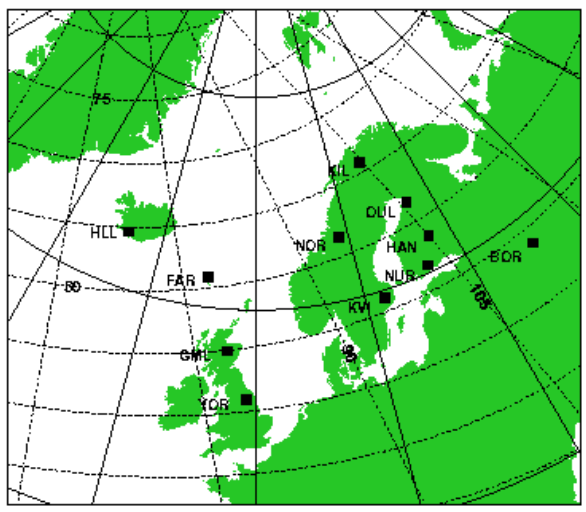
Fig. 10a. Map of stations in the SAMNET sub-auroral magnetome- ter array.